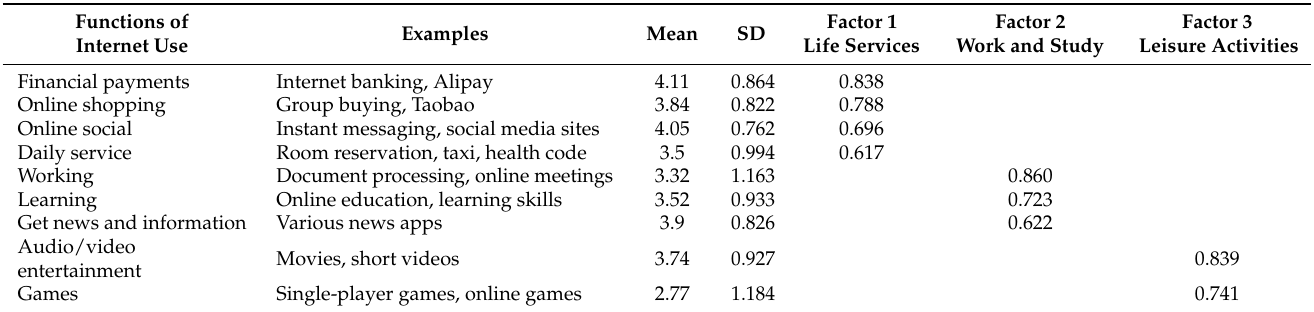
Table 2. Mean, standard deviation, and factor analysis of functions of internet use by middle-aged and older